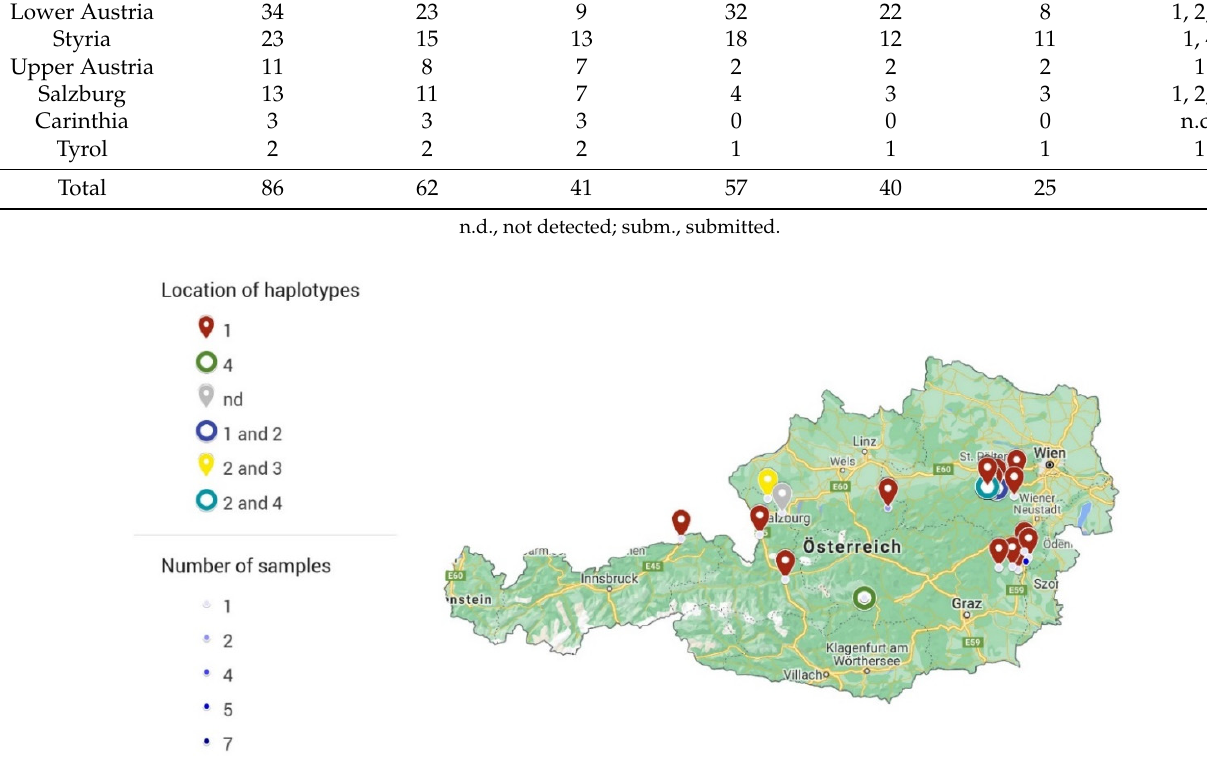
Figure 2. Location of haplotypes and number of positive samples submitted by town. Please visit https://www.google.com/maps/d/edit?mid=1zjFBQwKYfcNieR0q0vtQLkYcYkbKObSy&usp=sharing (accessed on 20 August 2021) for an interactive map.